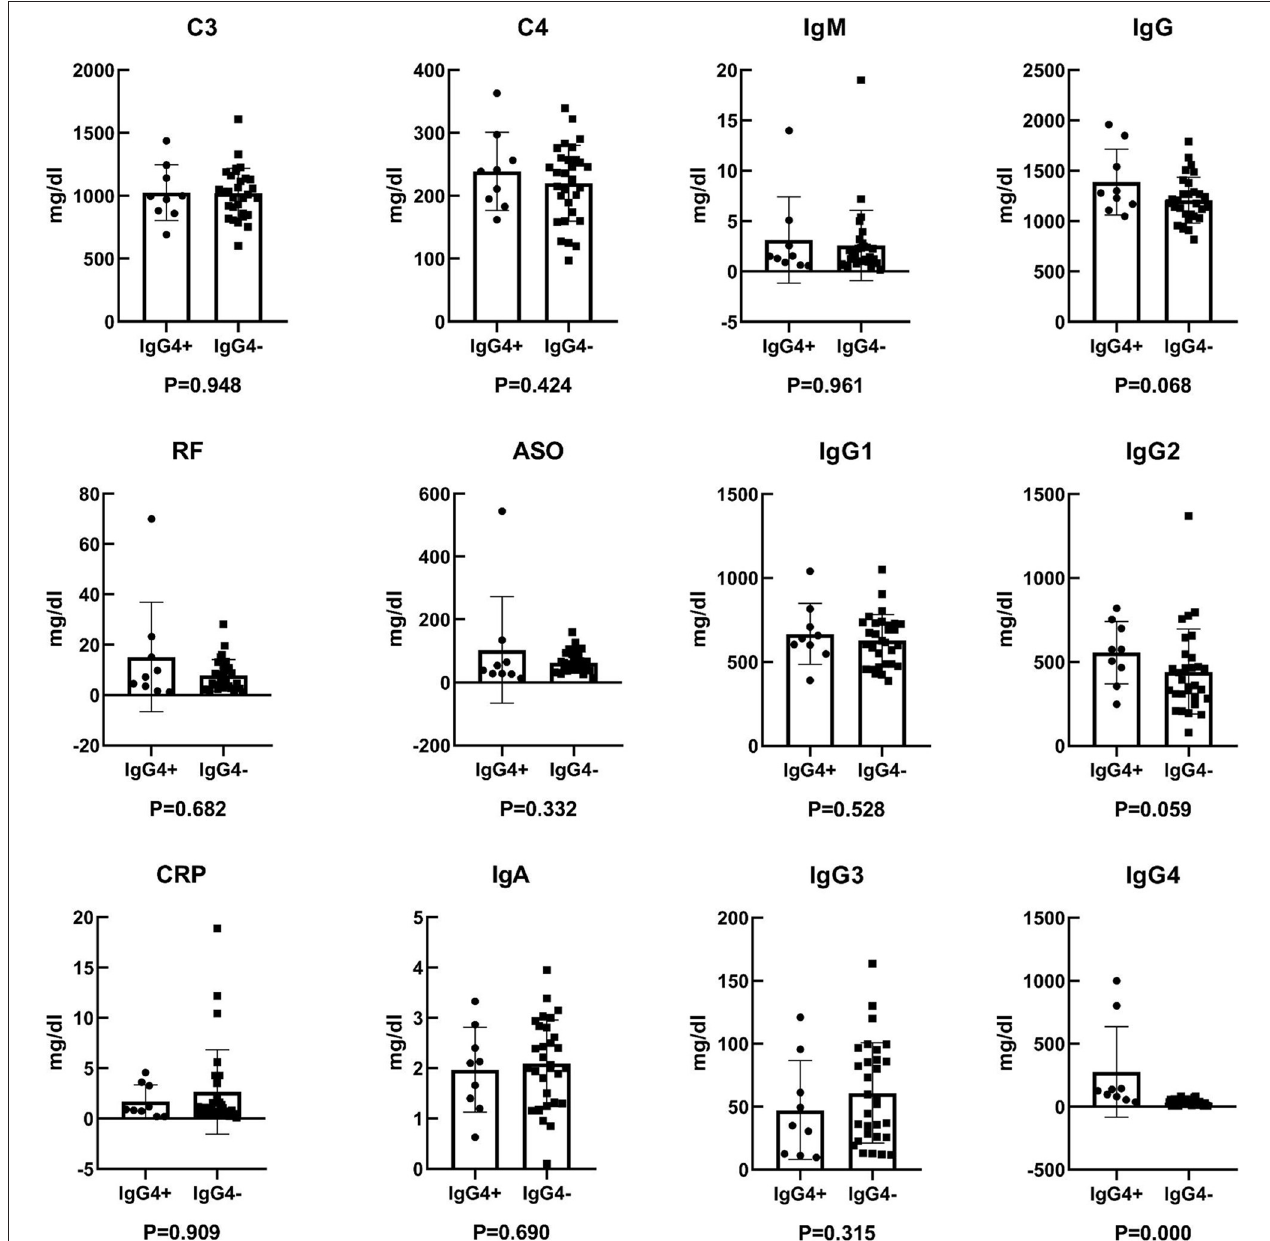
FIGURE 2 | Comparative analysis of laboratory indicators between IgG4 + and IgG4 − lymphoma. Comparison of C3 concentration, P = 0.948; comparison of C4 concentration, P = 0.424; comparison of RF concentration, P = 0.682; comparison of ASO concentration, P = 0.332; comparison of CRP concentration, P = 0.909; comparison of IgA concentration, P = 0.690; comparison of IgM concentration, P = 0.961; comparison of IgG concentration, P = 0.068; comparison of IgG1 concentration, P = 0.528; comparison of IgG2 concentration, P = 0.059; comparison of IgG3 concentration, P = 0.315; comparison of IgG4 concentration, P = 0.000. P < 0.05 indicates statistical